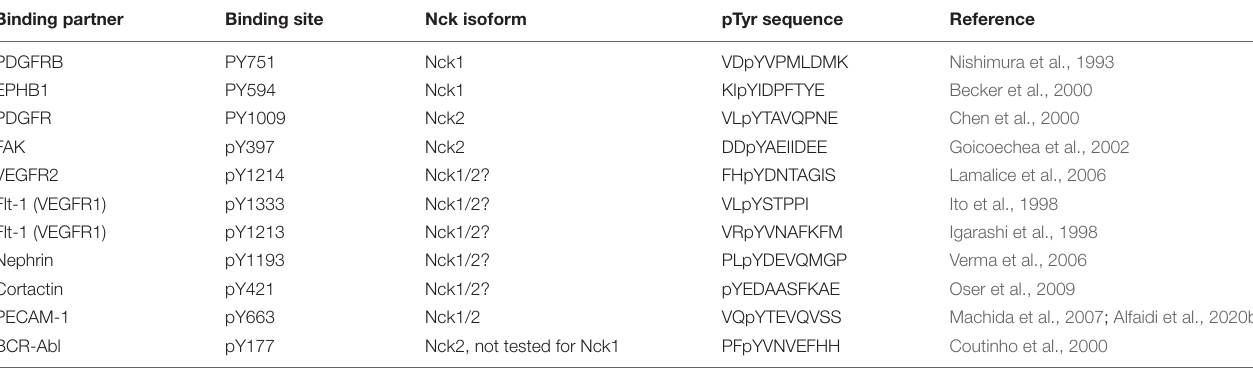
TABLE 1 | Some of the known Nck1/2 SH2 binding partners. Binding partner